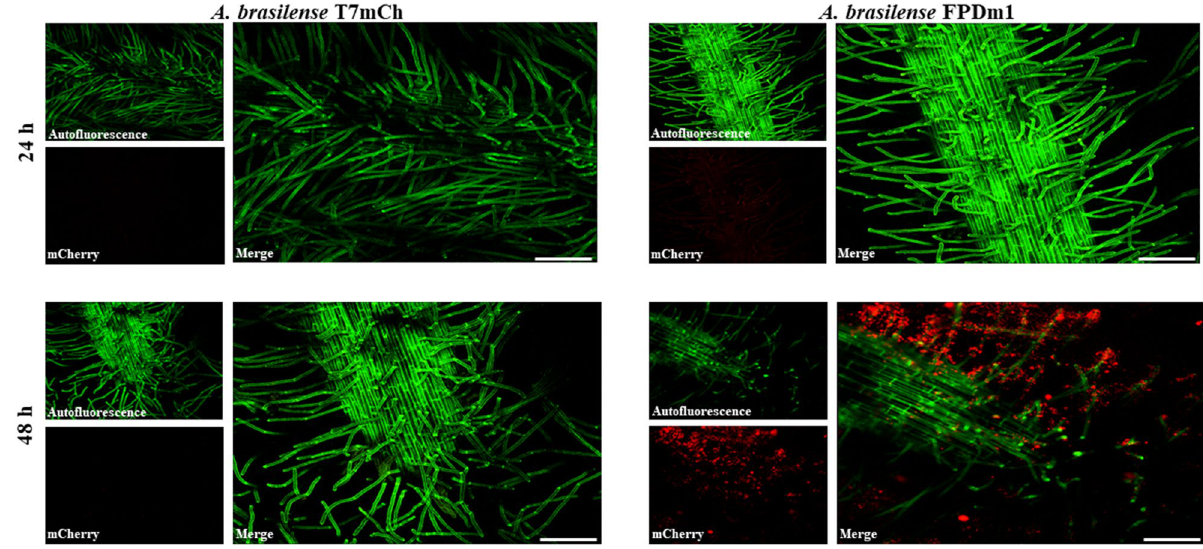
Figure 6. Expression of the pcdgD‑mCherry transcriptional fusion from A. brasilense cells grown under hydroponic conditions and in wheat roots. For the visualization of mCherry -expressing A. brasilense, cells on wheat roots were observed at 24 h and 48 h postinoculation. Next, the freshly harvested seedling roots were visualized in a FluoroDish. Left, wheat seedling roots inoculated with the A. brasilense T7mCh control strain. Right, wheat seedling roots inoculated with the A. brasilense FPDm1 strain. The cells exhibiting mCherry fluorescence were visualized using a CLSM with an excitation wavelength of 561 nm, with fluorescence